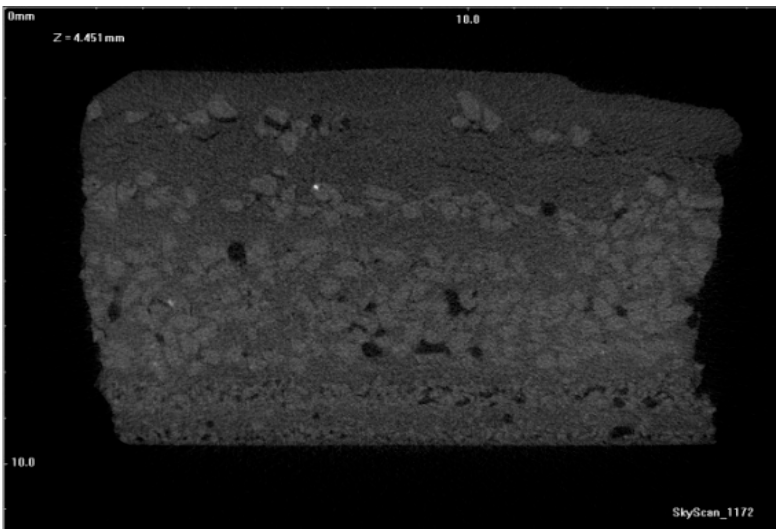
Figure 16. 2D ( a ) and 3D ( b ) profilographs of PW3 sample at a magnification of ×28.4.